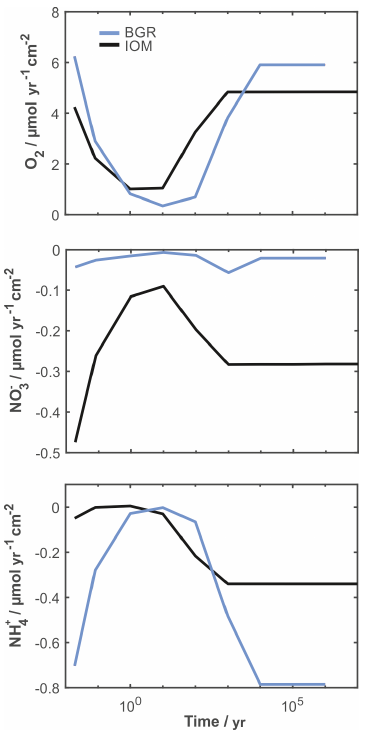
Figure 7. Pore-water fluxes of oxygen (O 2 ), nitrate (NO − monia (NH + ) at the sediment–water interface obtained by the ap- 4 plication of the transient transport-reaction model. Oxygen fluxes into the sediment and fluxes of nitrate and ammonia towards the sediment surface are shown as a function of time after the EBS and IOM-BIE disturbances in the German BGR-RA area (blue) and in the eastern European IOM area (black),